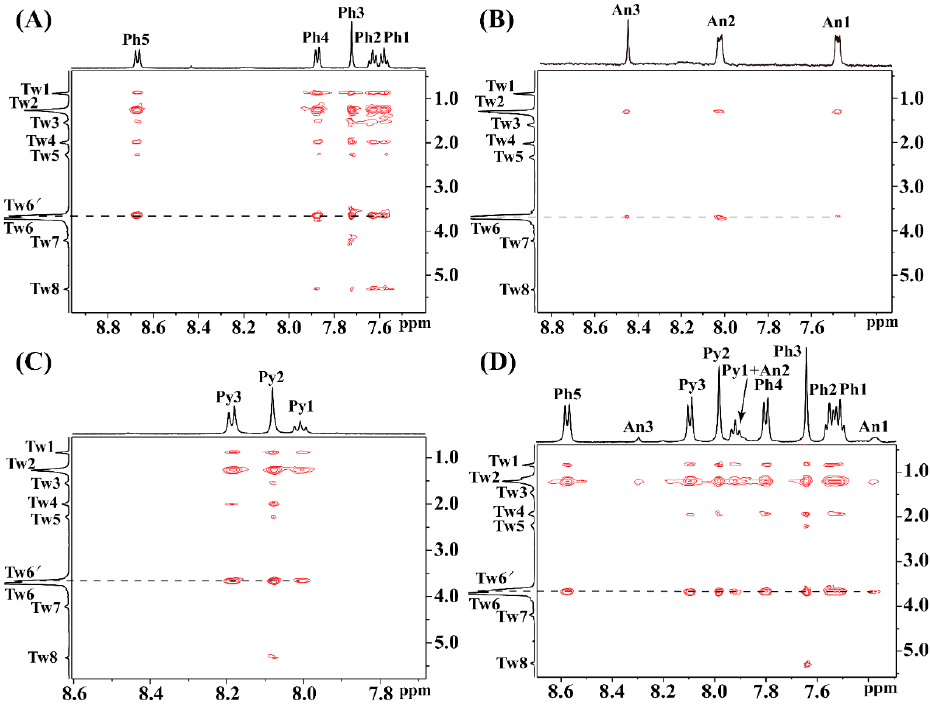
Figure 6. Partial ROESY spectra of single Phe ( A ), Ant ( B ), Pyr ( C ) and ternary Phe-Ant-Pyr systems ( D ) at the Tween 80 concentration of 50 mM with the mixing time of 0.2 s.